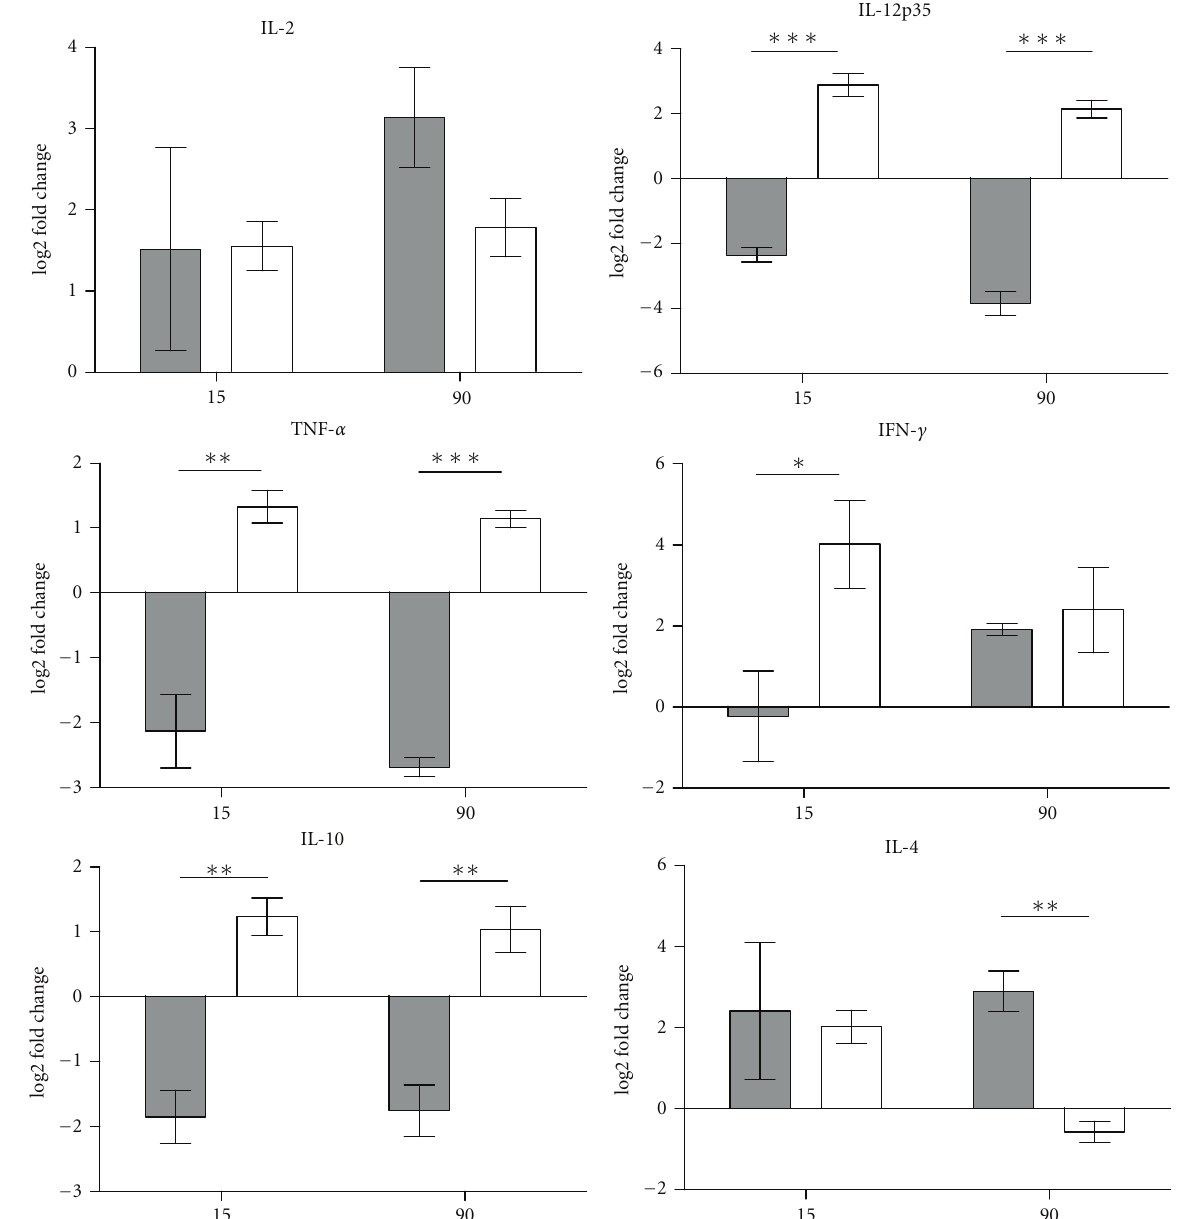
Figure 4: Relative cytokine gene expression. Gene expression was measured in PBMCs from animals infected with either Mb Δ mce2 ( n = 4, white bars) or NCTC 10772 ( n = 3, gray bars) stimulated with PPDB at 15 and 90 dpi. Relative gene expression was calculated using the 2- ΔΔ Ct method with E correction, using pol II and gadph mRNA expression as reference genes and the preimmune condition as the calibrator. Data were analyzed using a two-tailed unpaired t -test ( ∗∗ P < 0 . 01, ∗∗∗ P < 0 . 001). The bars indicate the average ratios of infected animals/uninfected animals ±